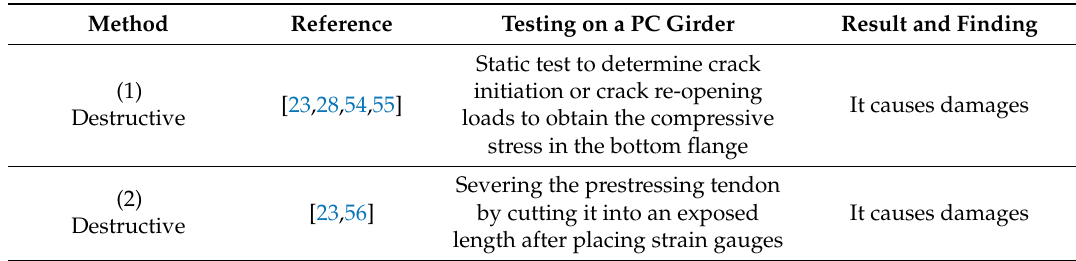
Table 3. Testing methods for determining prestress losses in PC